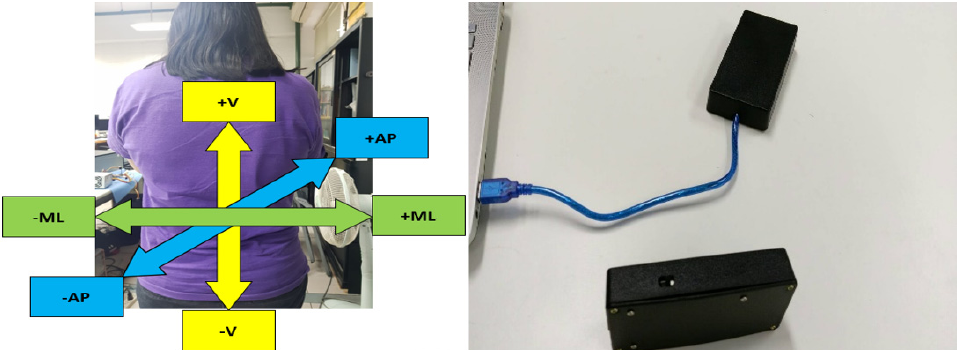
Figure 1. Schematic diagram of the sensor with a visualization of the three axes.